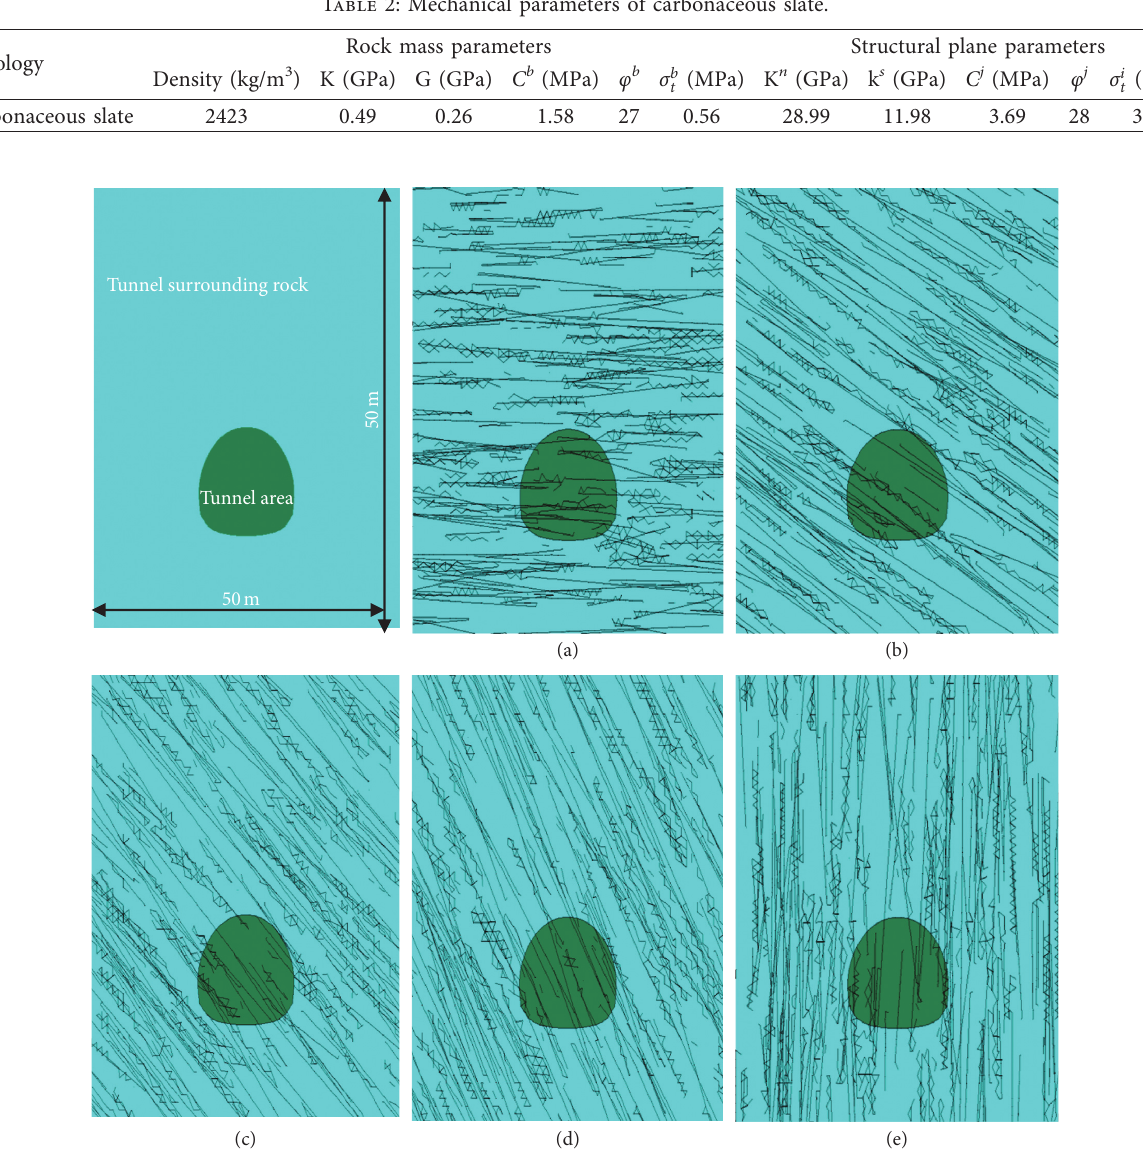
Figure 4: Numerical calculation model of different surrounding rock inclination. (a) The dominant joint angle 0 degrees. (b) The dominant joint angle 30 degrees. (c) The dominant joint angle 45 degrees. (d) The dominant joint angle 60 degrees. (e) The dominant joint angle 90